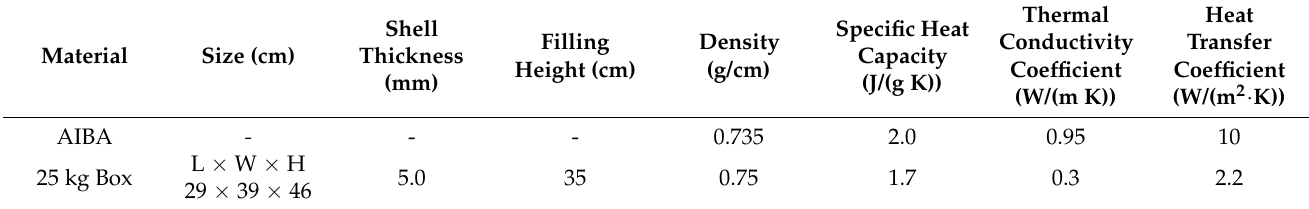
Table 3. Physical parameters of AIBA and packages for AIBA.